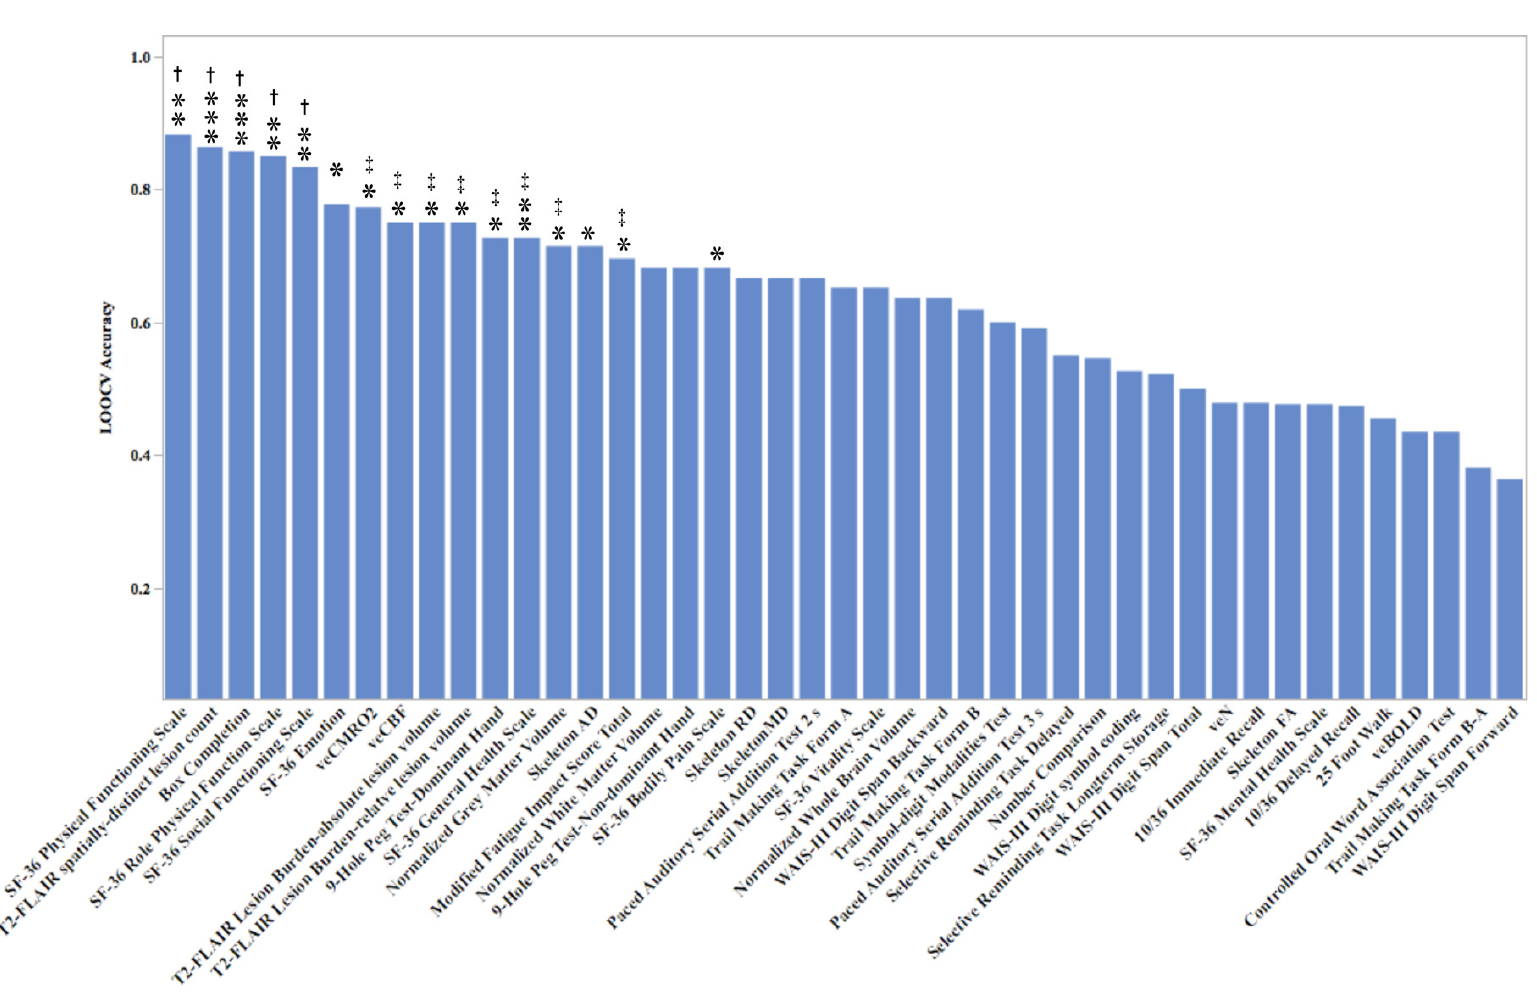
Figure 7. Leave-one-out cross-validation (LOOCV) out-of-sample classification accuracy of each model. * p < 0.05; ** = p < 0.01; *** = p < 0.001. † p -value also significant using Benjamini-Hotchberg correction ( p < 0.05). ‡ p -value marginally significant using Benjamini-Hotchberg correction ( p <